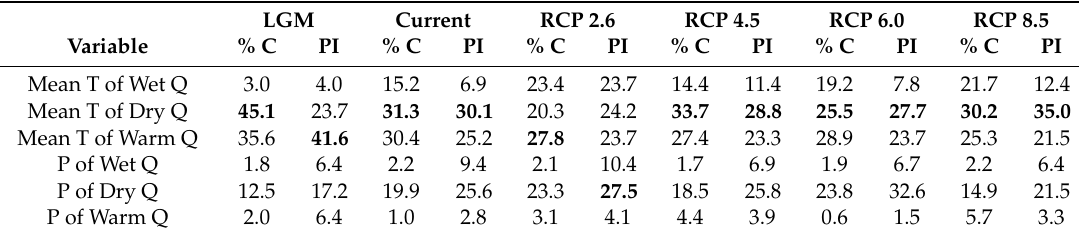
Table 4. For each climate scenario model is presented the percent contribution (% C) and permutation importance (PI) for each environmental predictor variable with the highest contribution in bold . All temperature variables are in ( ◦ C) and all precipitation variables are in (mm). Abbreviations are: